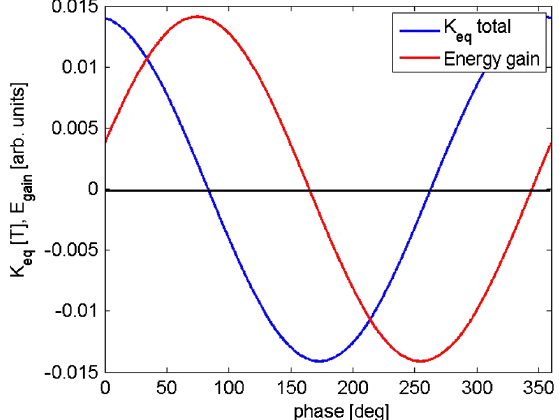
FIG. 3. Electric field on the cathode as a function of time in different cases. FIG. 4. Integrated quadrupole gradient as a function of the injection phase.